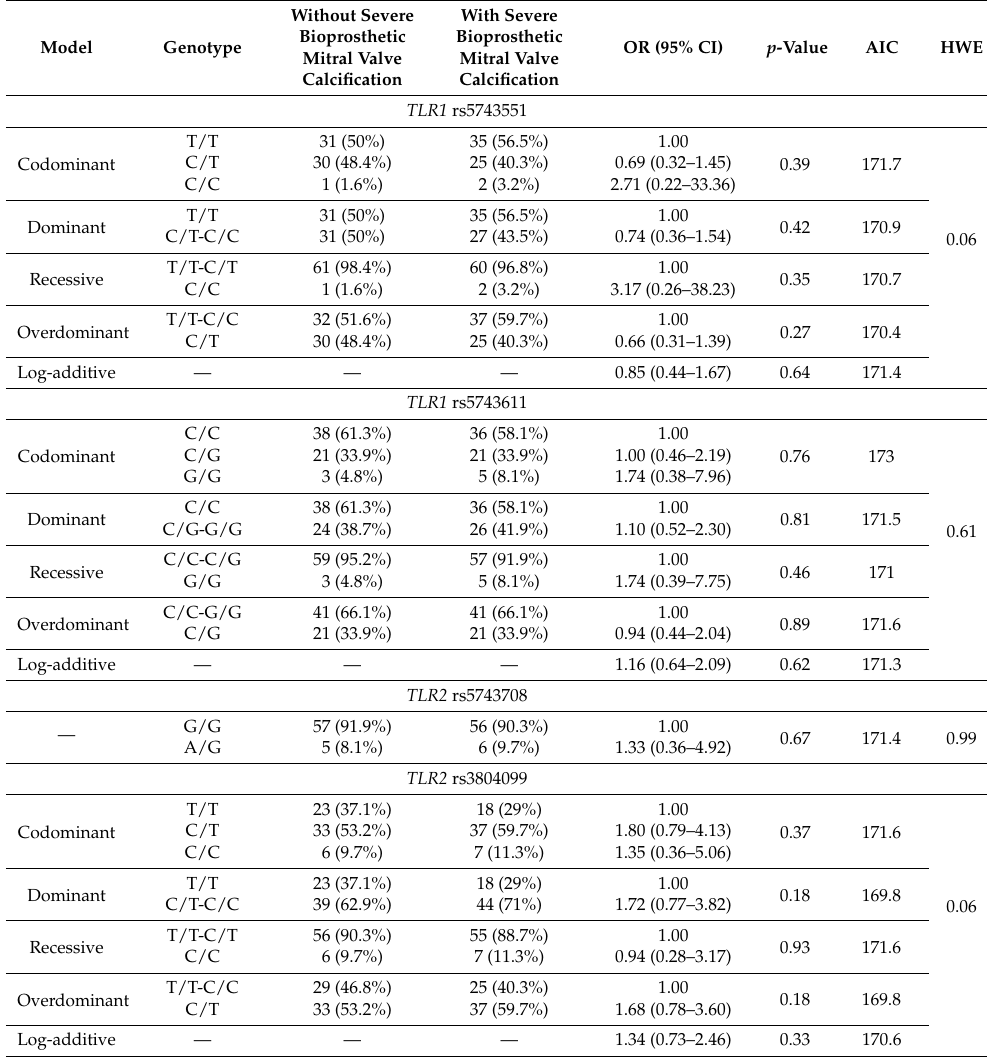
Table 1. Association of the polymorphisms within innate immunity genes, genes of lipid metabolism, and genes of calcium metabolism with severe bioprosthetic mitral valve